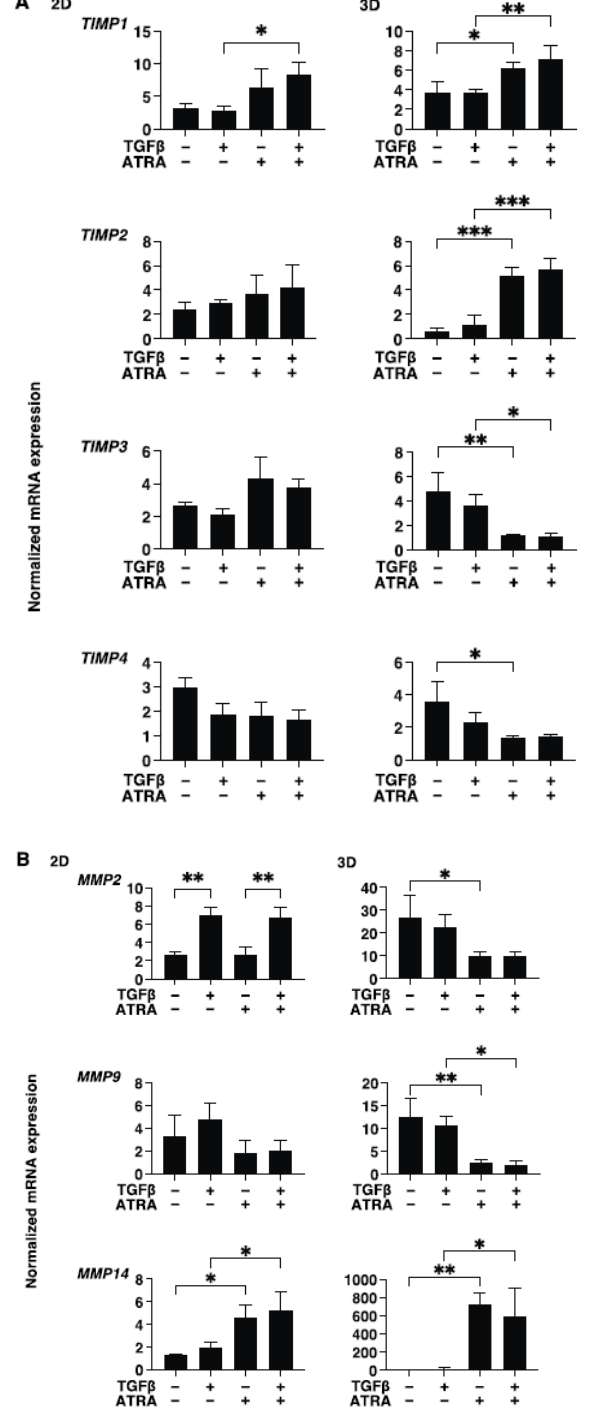
Figure 6. Effects of ATRA toward the gene expression of TIMPs and MMPs of the TGF- β 2 treated and untreated HconF cells. Two-dimensional and three-dimensional HconF cells untreated and treated with TGF- β 2 (TGF β , 5 ng/mL) were subjected to qPCR analysis to evaluate the expression of mRNA in TIMP1-4 ( A ) and MMP2 , 9, and 14 ( B ) , in the presence or absence of 1 μ M ATRA. All experiments were performed in triplicate using 3 different confluent 6-well dishes (2D) or 15 freshly prepared 3D HconF spheroids (3D) in each experimental condition. Data are expressed as the mean ± standard error of the mean (SEM). * p < 0.05, ** p < 0.01 and *** p < 0.005; ANOVA followed by a Tukey’s multiple comparison